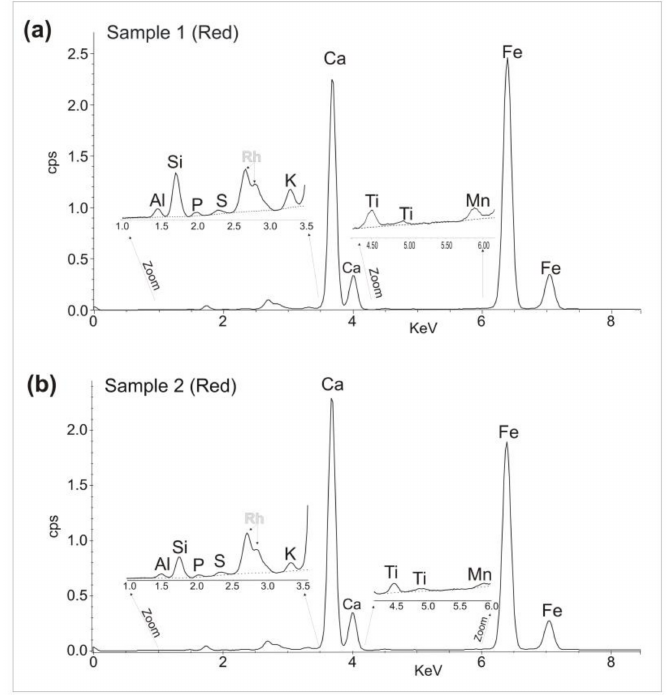
Figure 3. Portable X-ray fluorescence (P-XRF) spectra of the red painted surfaces of Samples 1 ( a ) and 2 ( b ).